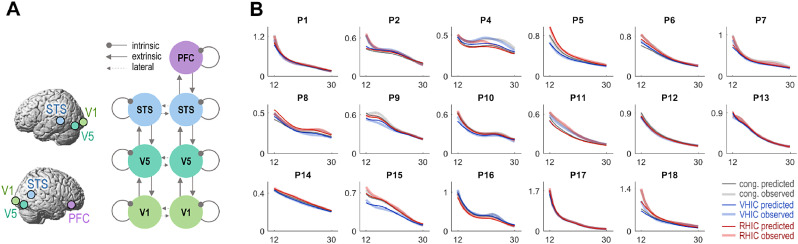
DCM architecture. A: A hierarchical cortical network was constructed based on the source localization of significant spectral differences between conditions; including the bilateral V1, V5, STS, and the right PFC (shown schematically, cf. Fig. 2). B: Individual model fits showing the first principal eigenmode of the prediction in sensor space (thin lines) and the corresponding mode of the empirical scalp data (thick lines) for the congruent ‘baseline’, and the VHIC and RHIC conditions. (For interpretation of the references to colour in this figure legend, the reader is referred to the web version of this article.)